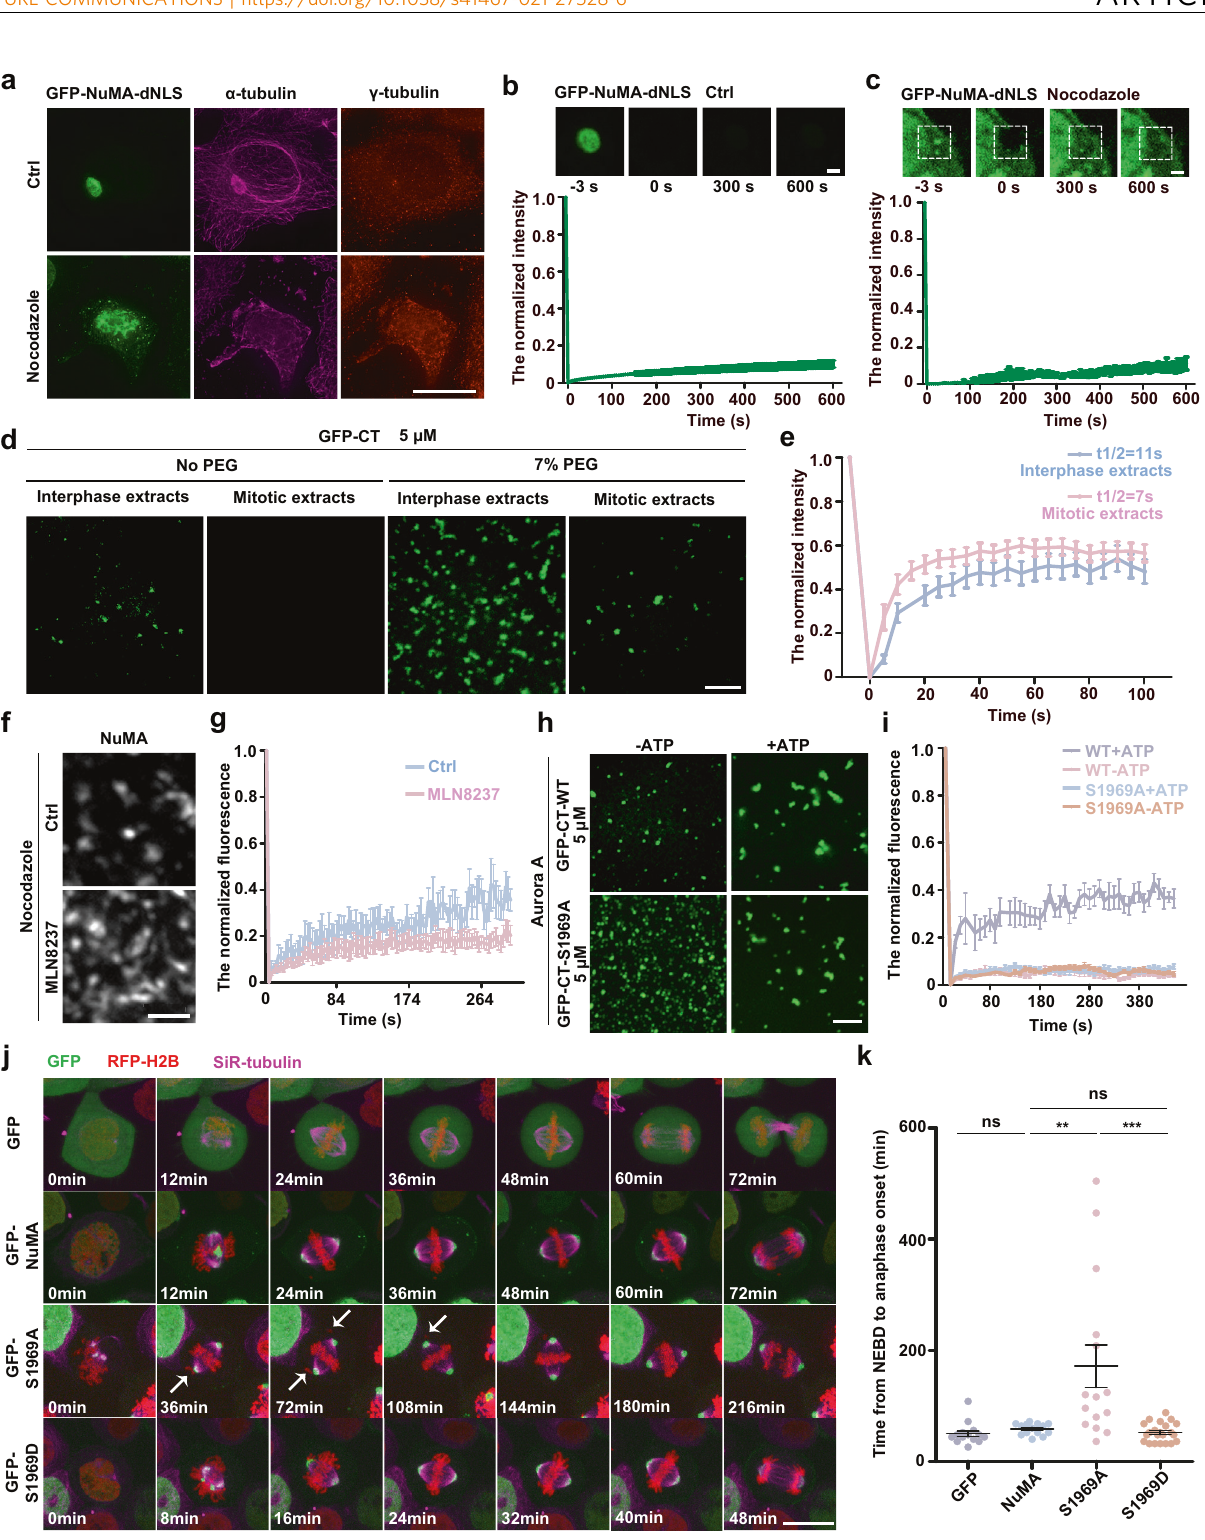
large NuMA droplets were split into numerous smaller tubulin- containing droplets (Fig. 4a). However, under FRAP, these interphase NuMA droplets were less dynamic and more stable than mitotic NuMA droplets regardless of nocodazole treatment (Fig. 4b, c). To further prove that NuMA statuses in interphase and in mitosis were different, we performed experiments in vitro. The results showed that GFP-CT proteins formed less droplets when added to mitotic cell extracts than when added to